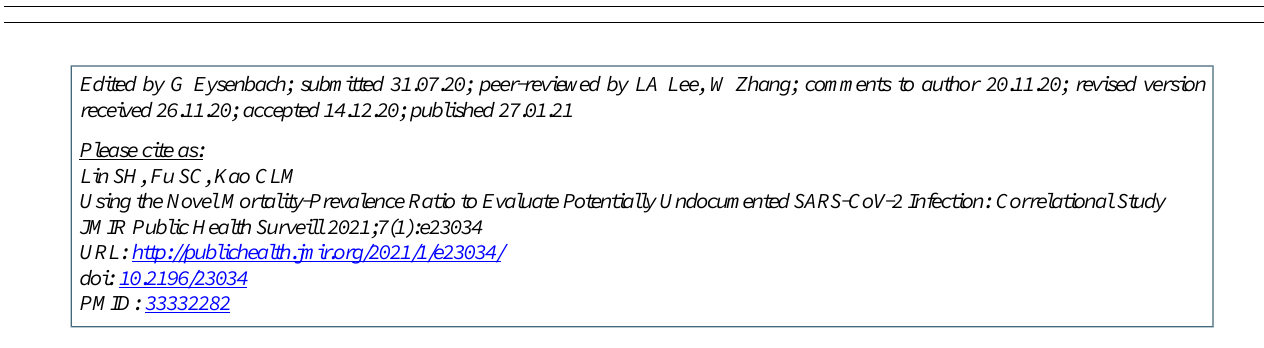
SARS: severe acute respiratory